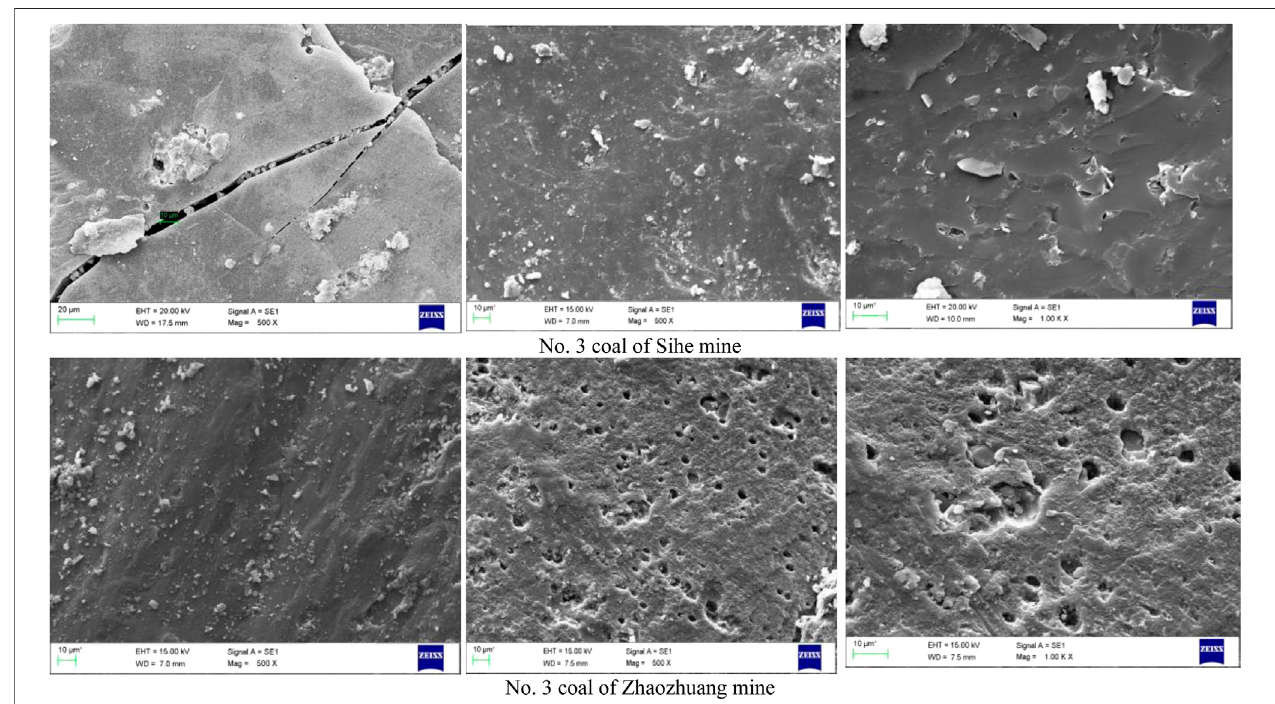
FIGURE 6 | Pore-fracture system development of coal seam by SEM observation.